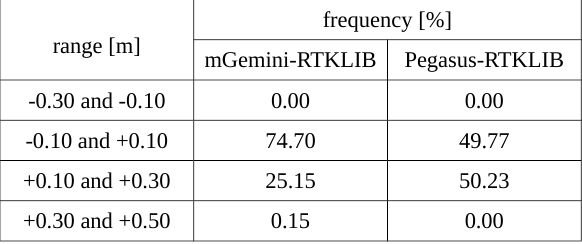
Table 4. Difference in fast and long term correction variances